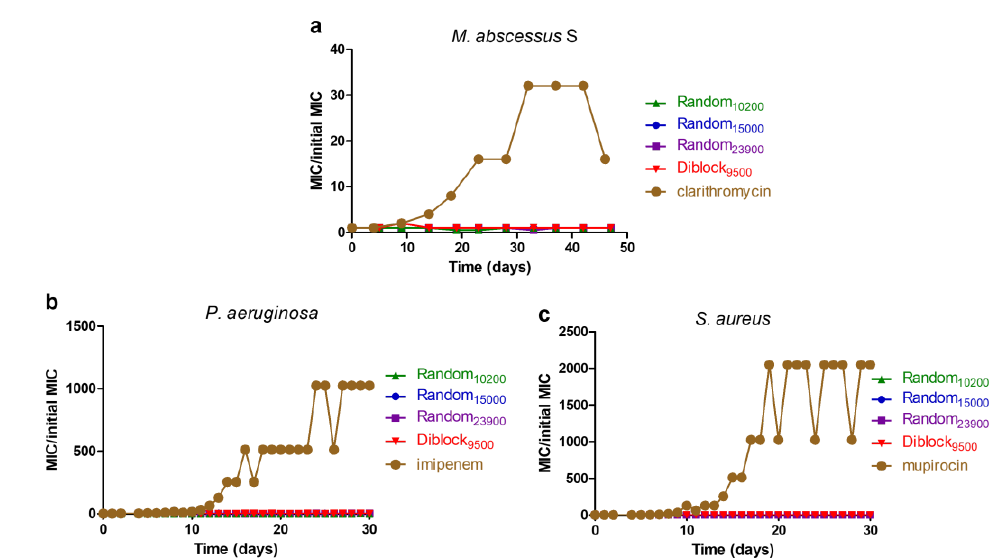
Figure 7. Evaluation of the acquisition of resistance caused by copolymers. Induction of resistance caused